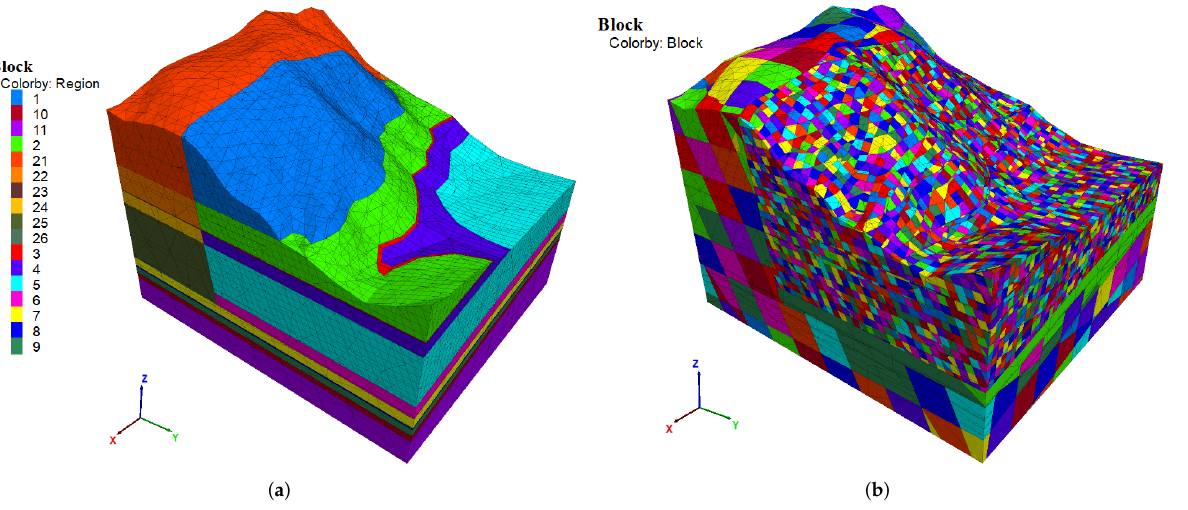
Figure 10. Computational models divided by region and block. ( a ) Model divided by region, ( b ) model divided by